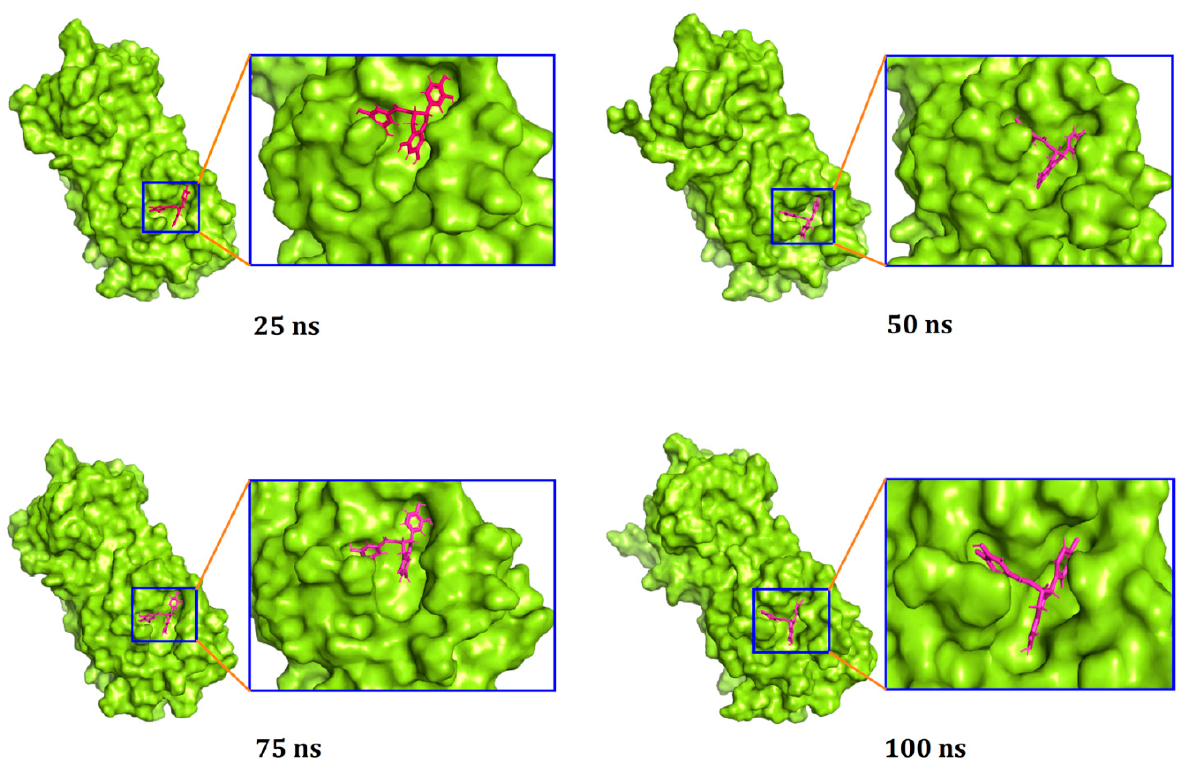
Figure 5. Surface views for the docked complex in the molecular dynamics simulation. The snapshots were taken at 25, 50, 75, and 100 ns, respectively, for (+)-epicatechin-3-O-gallate and the M pro complex.